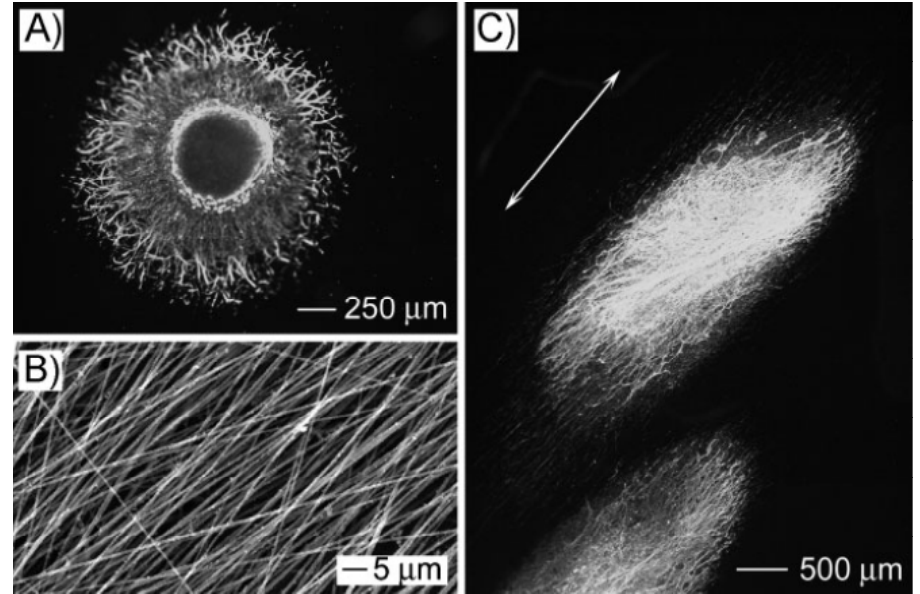
Figure 8. ( A ) Fluorescence image of DRG neurite field on random PCL-PPy core-sheath nanofibers; ( B ) SEM Image of aligned PCL-PPy core-sheath nanofibers; ( C ) Fluorescence image of DRG neurite field on aligned PCL-PPy core-sheath nanofibers. Reprinted from [286] with permission from John Wiley and